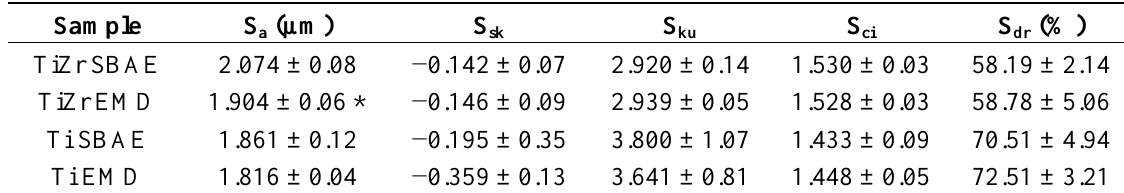
Table 4. Mean surface topography parameters with standard deviation assessed by optical imaging profilometry. Only TiZr EMD showed a significant difference (* p < 0.05) for S compared to TiZr SBAE. a